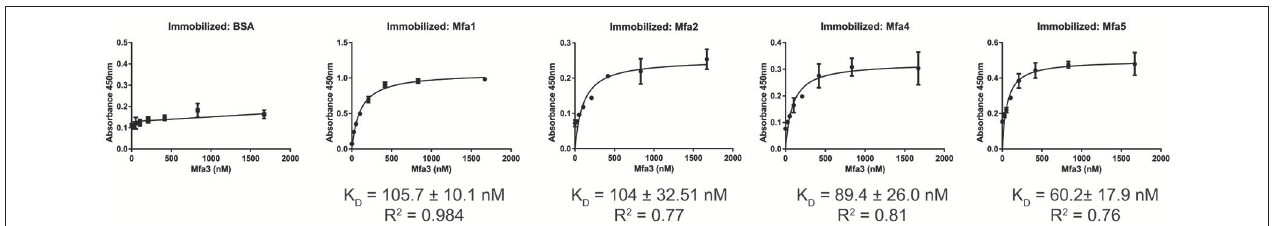
FIGURE 1 | ELISA of binding between post-Rgp processed Mfa3 and other Mfa proteins. Rgp-processed forms of Mfa1 or Mfa4, along with recombinant Mfa2 or Mfa5 (1 µ g) were immobilized on a microtiter plate. BSA was used as a control. Binding of Rgp-processed Mfa3 at the concentrations indicated was detected with antibodies to Mfa3 (1:5,000) followed by secondary anti-rabbit IgG HRP-linked antibodies (1:5,000). Signals were developed with the TMB substrate and absorbance values were measured at 450nm. The binding data were analyzed using a 1:1 saturation binding model, and K D and R 2 values are shown. The data are from 3 independent